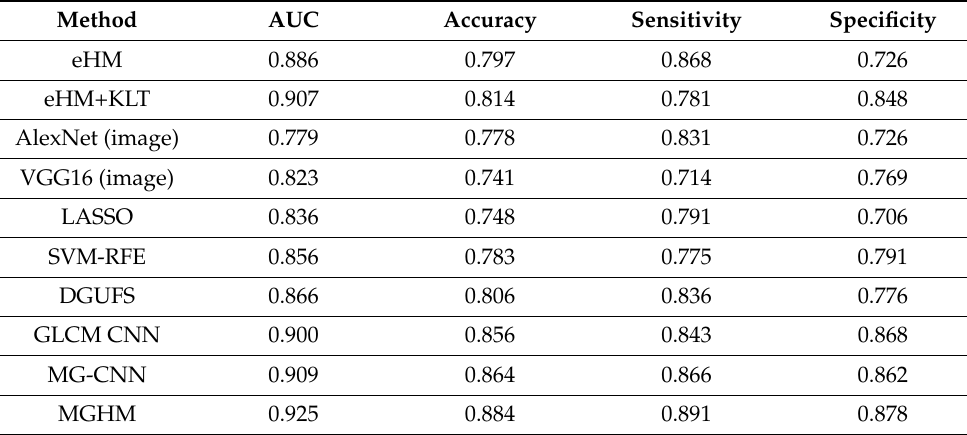
Table 8. Four evaluation measurements of proposed and comparative